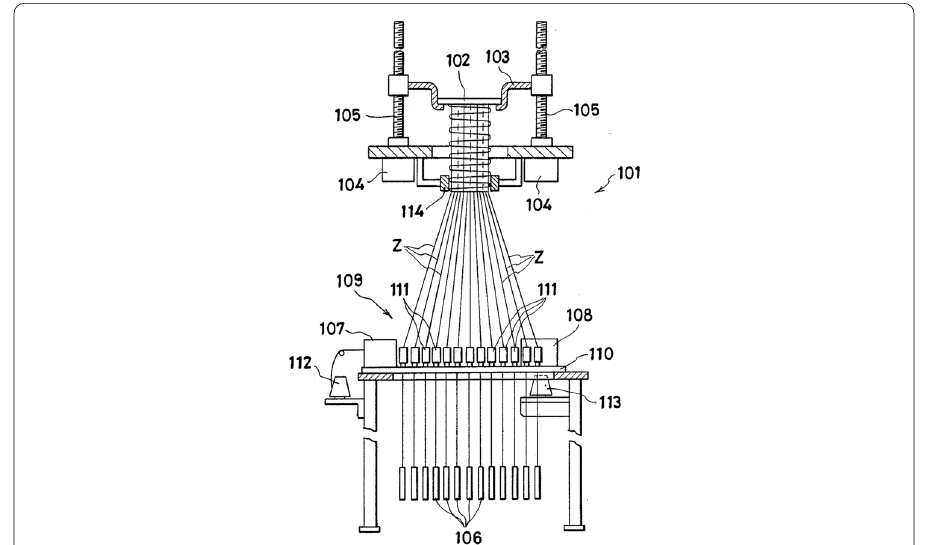
Fig. 2 Plan view of the device by Fukuta et al. (1986). 102—vertical yarn supporting plate, 103—fixing frame, 104—motor, 105—threaded shafts, 106—weights, 107,108—package stations, 109—weaving device, 110— carrier fixing plate, 111—carriers, 112—coiled yarns for lateral yarns, 113—coiled yarns for longitudinal yarns, Z—vertical